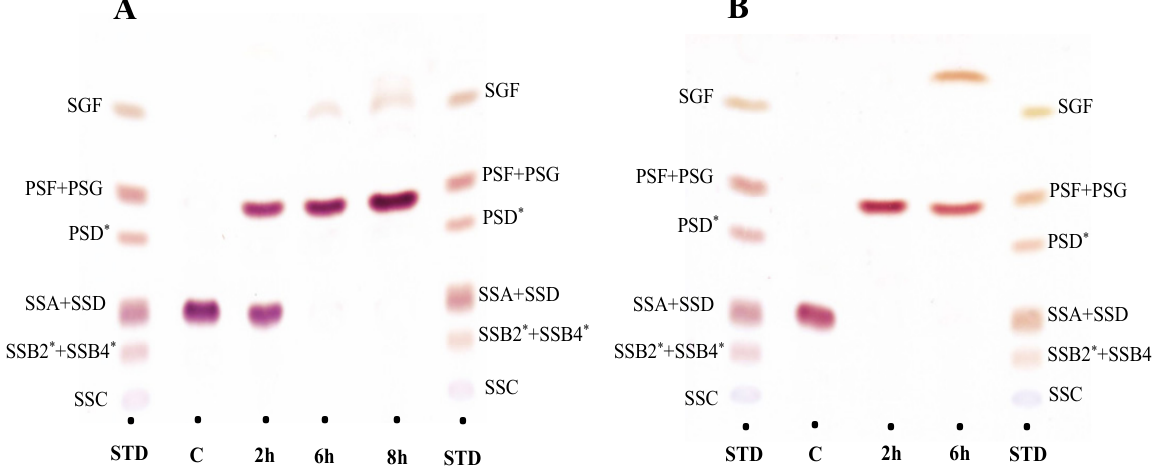
Figure 3. Time-course thin layer chromatography (TLC) analyses of saikosaponin A and D biotrans- formation by BglPm and BglLk, respectively; ( A ) TLC analysis of biotransformation saikosaponin A by BglPm.; Lane STD, saikosaponin standard; Lane C, substrate saikosaponin A; Lane 2 h, the reaction after two-hours treatment with BglPm; Lane 6 h, the reaction after six-hours treatment with BglPm; Lane 8 h, the reaction after eight-hours treatment with BglPm. ( B ) TLC analysis of biotransformation saikosaponin D by BglLk.; Lane STD, saikosaponin standard; Lane C, substrate saikosaponin D; Lane 2 h, the reaction after two-hours treatment with BglLk; Lane 6 h the reaction after six-hours treatment with BglLk. * “SSB2” means saikosaponin B2; “SSB4” means saikosaponin B4; “PSD” means prosaikogenin